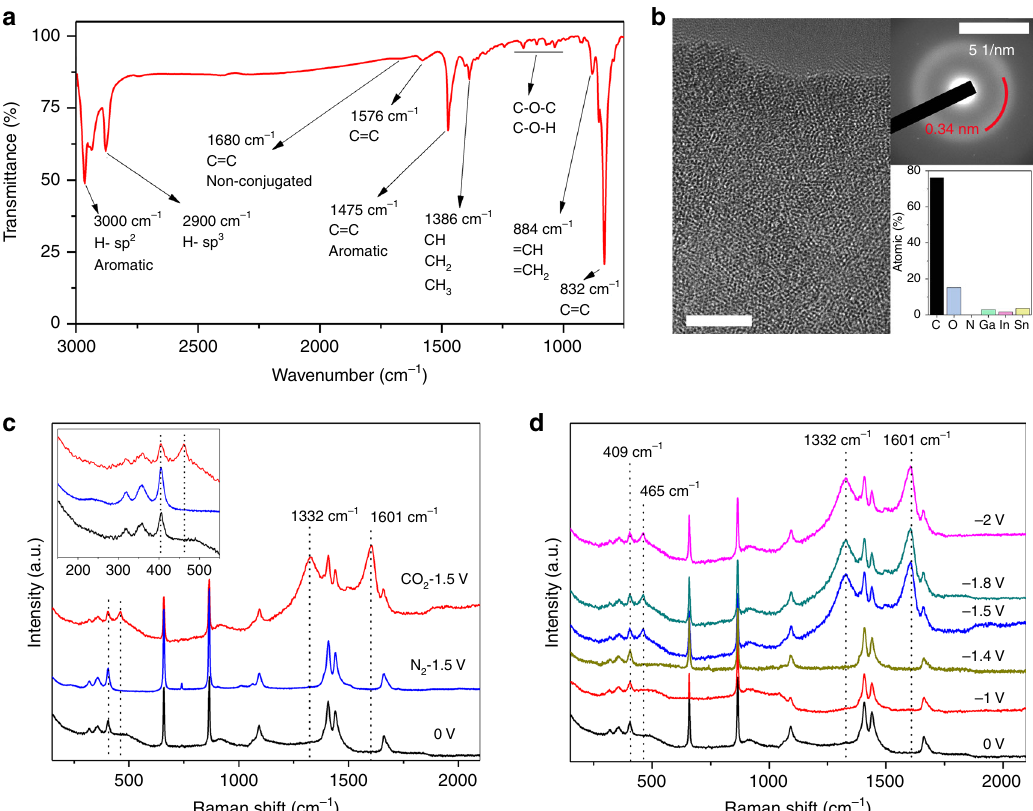
Fig. 2 Characterisation of carbonaceous materials. a Fourier transform infra-red (FTIR) spectrum of the isolated carbonaceous materials, featuring intense FTIR absorption lines at 832 and 1475 cm − 1 which are characteristic of C = C bonds. b High-resolution transmission electron microscopy (HRTEM) image of isolated layered carbonaceous materials (scale bar, 5 nm), with selected area electron diffraction (SAED) image (inset, scale bar 5 1/nm) and elemental composition determined by EDS (inset). c Raman spectroscopic measurement of carbonaceous materials on a liquid galinstan alloy containing 3 wt% Ce (LMCe3%) surface after electrochemical reduction in CO 2 and N 2 saturated electrolytes measured at 0 and − 1.5 V vs. Ag/Ag + . Inset: magni fi ed view of the Raman peaks at 409 and 465 cm − 1 . d Operando Raman spectra of the LMCe3% surface during electrocatalysis at indicated